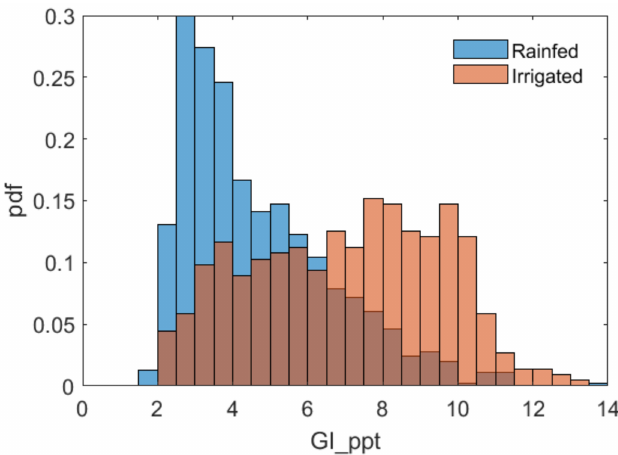
Figure 5. Empirical probability density function of green index following maximum dryspell (GI_ppt) estimated from manually labelled